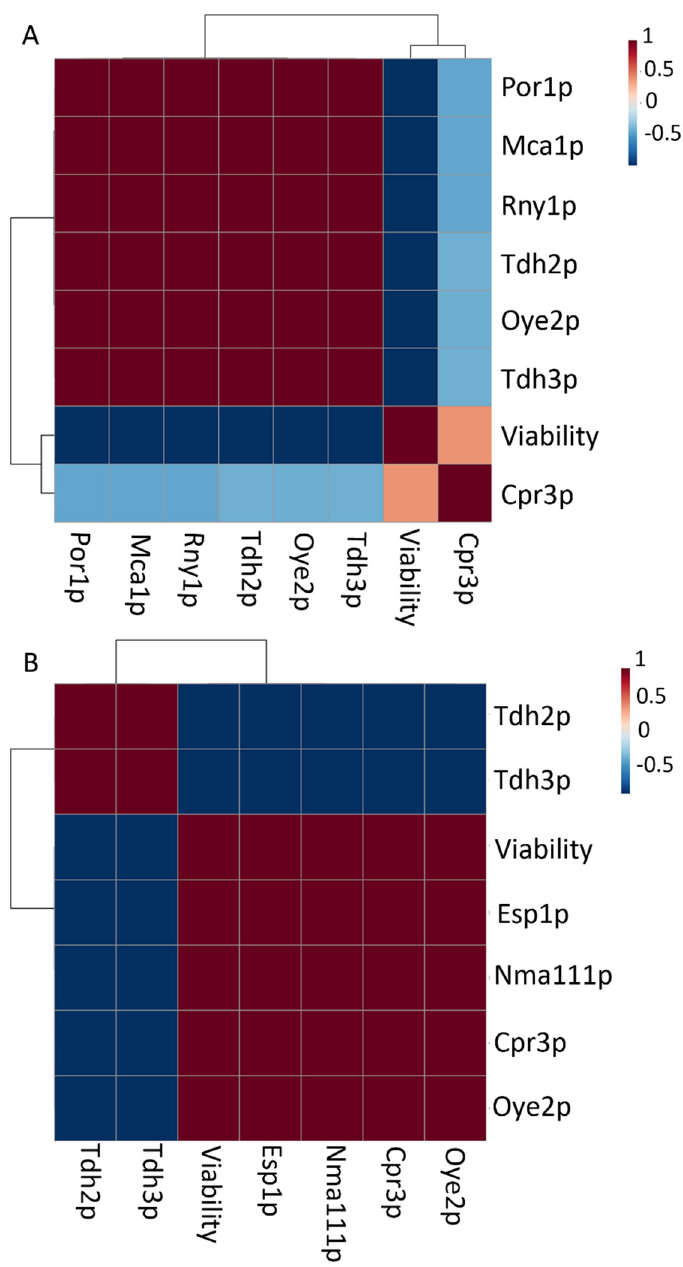
Figure 5. Correlation matrix and clustering analysis based on the content of normalized and scaled data of apoptosis proteins and cell viability observed under CO 2 overpressure conditions in: ( A ) S. cerevisiae P29 and ( B ) G1.